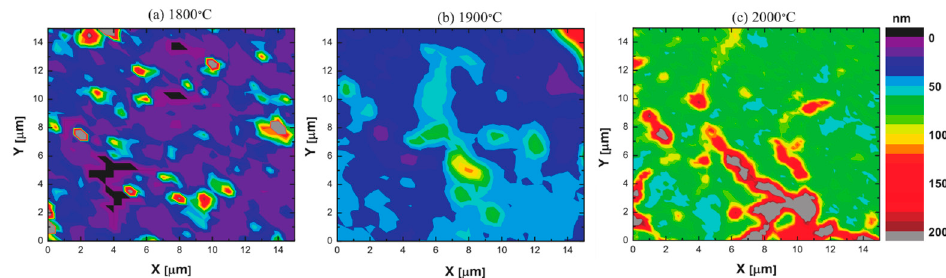
Figure 30. Three 15 µm 2 color-coded maps of in-plane crystallite size for the graphene grown at: ( a ) 1800 °C; ( b ) 1900 °C; ( c ) 2000 °C. The color bar represents the crystallite size in nm. The gray color in the bar represents a defect free area. The step is 0.5 µm for the maps in ( a ) and ( b ) and 0.25 µm for the map in ( c ) [141].